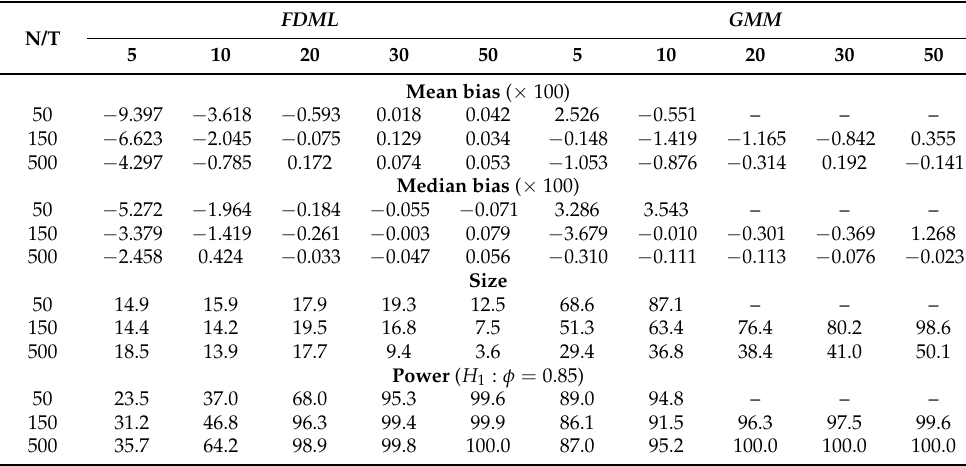
Table 2. Mean bias, median bias, size and power for φ = 0.95.